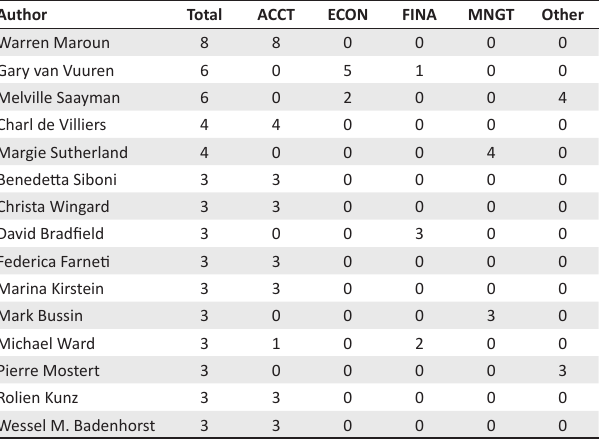
TABLE 8: Most prolific authors (number of articles 2015–2016).